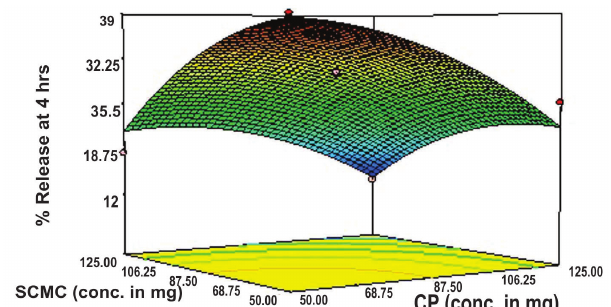
FIGURE 6 - Response surface plot showing the influence of CP and SCMC on the rel value of mucoadhesive tablet 4hrs formulations of flurbiprofen.